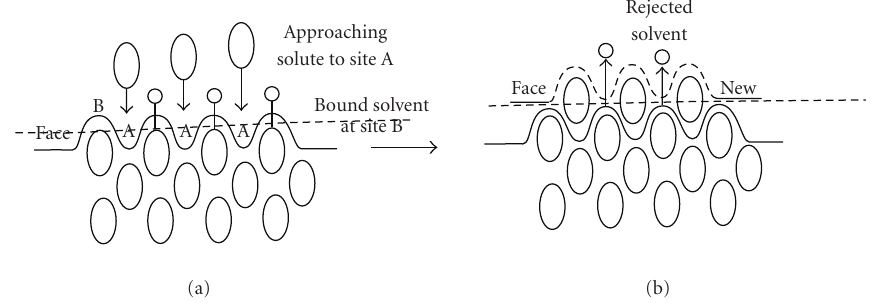
Figure 2: Mechanism of crystal growth by selective solvent binding in amino acids.